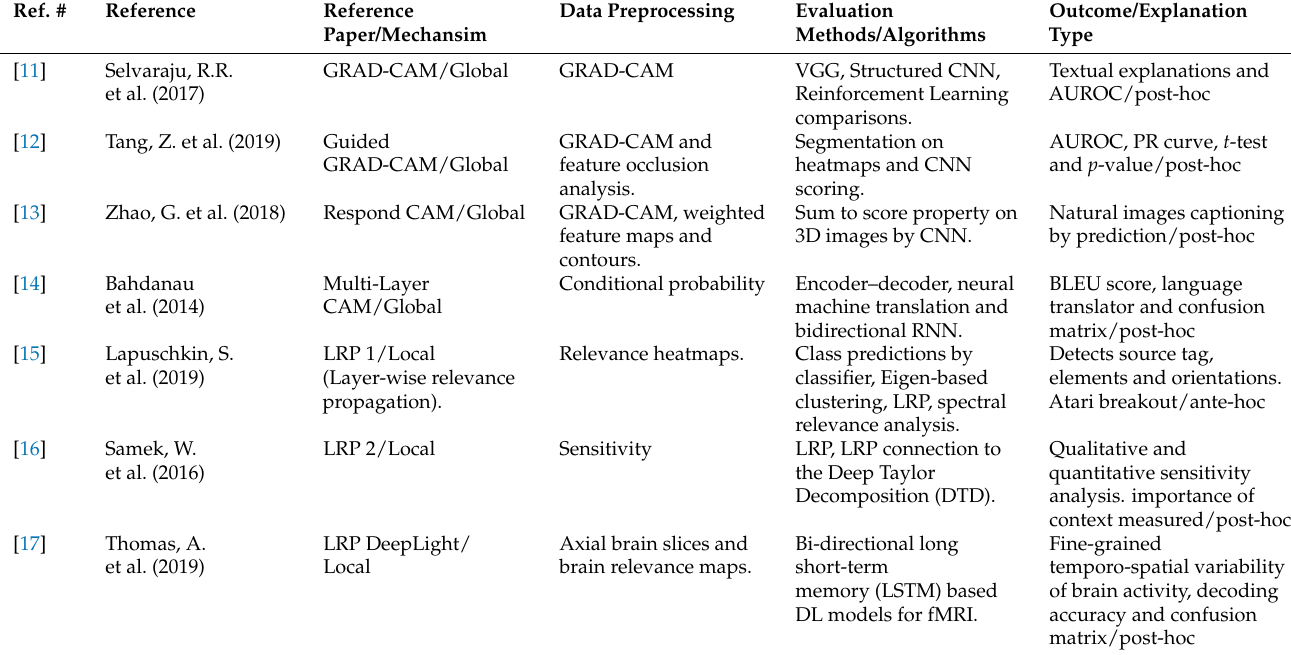
Table 1. General analysis for the explanation-based